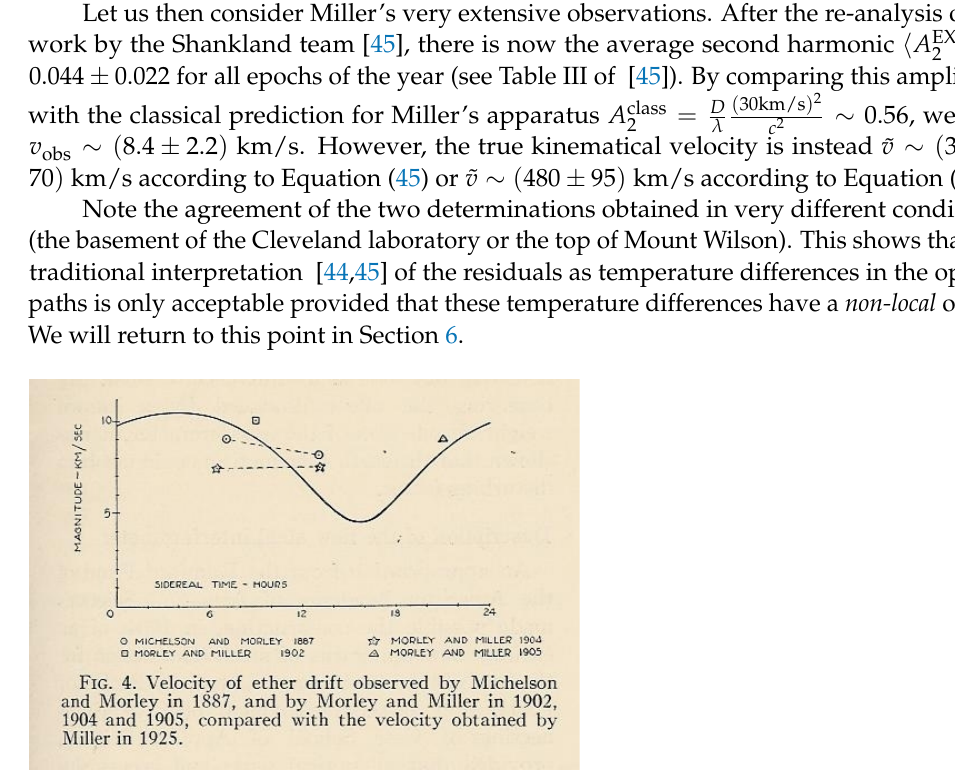
Figure 3. The observable velocity measured in various experiments reported by Miller